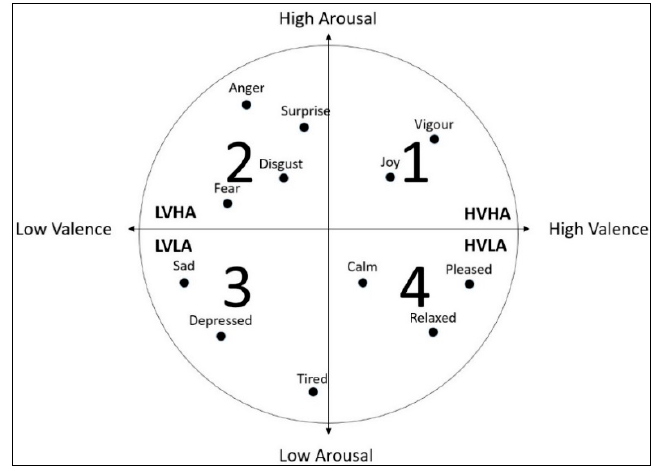
Figure 5. The Valence–Arousal dimension model of human emotion.